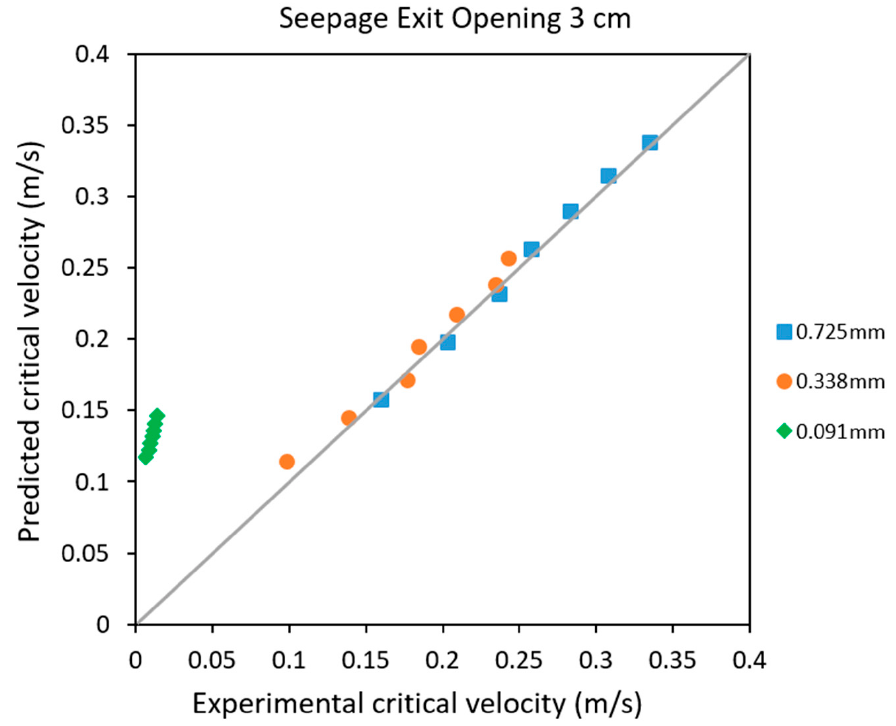
Figure 11. Comparison between predicted and experimental results with the seepage exit opening of 3 cm.